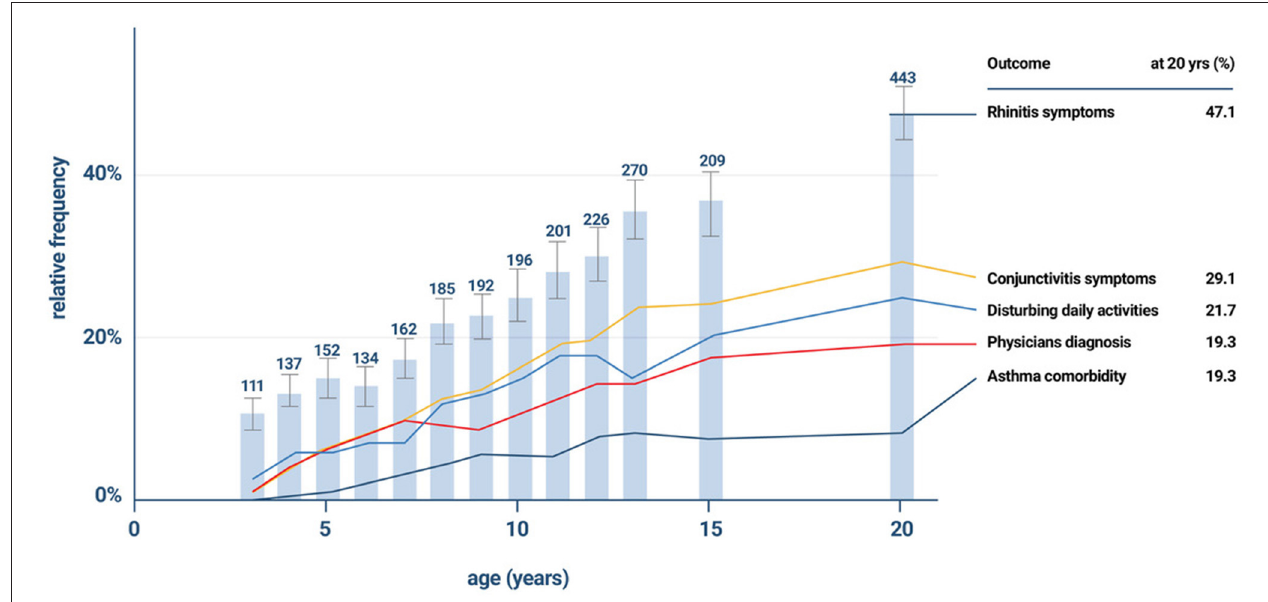
FIGURE 2 | The gradual increase in the incidence of rhinitis symptoms and co- morbidities in the the German Multicentre Allergy Study (MAS), which began in 1990 in five German cities and included 1,314 newborns for the study of the natural course of atopic diseases (26,